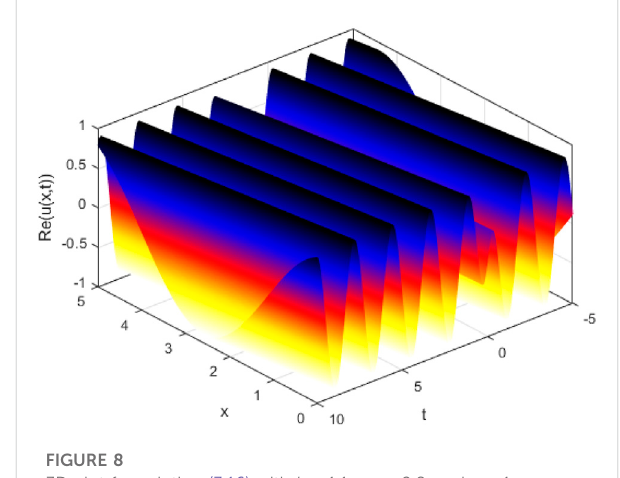
FIGURE 8 3D plot for solution (3.16) with k = 1.1, c = − 2.8, and γ = 1.